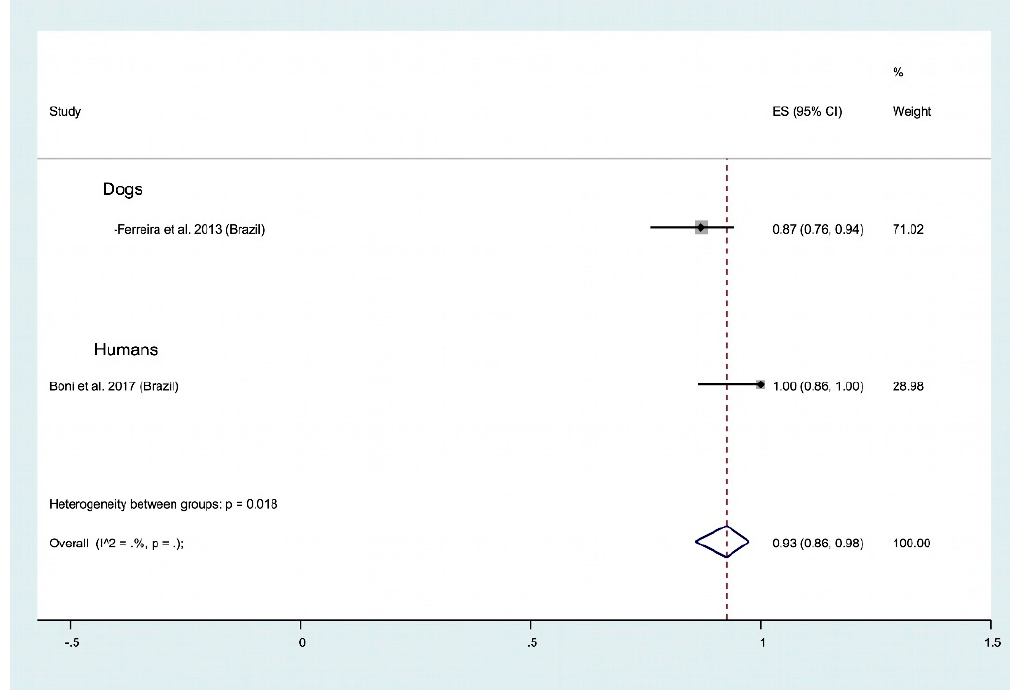
Figure 9. Forest plot representation of the extracted data for nasal secretion using molecular detection methods on dogs and human suffering leishmaniasis.